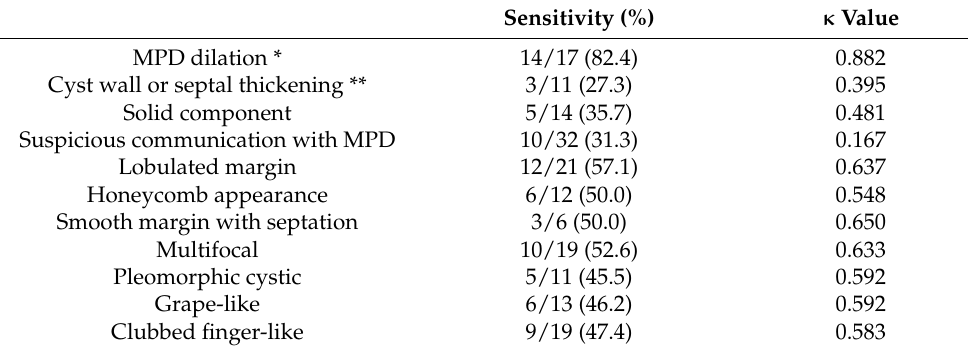
Table 4. Capability of US to characterize PCLs as a reference standard using EUS. Sensitivity (%) κ Value MPD dilation * 14/17 (82.4) 0.882 Cyst wall or septal thickening ** 3/11 (27.3) 0.395 Solid component 5/14 (35.7) 0.481 Suspicious communication with MPD 10/32 (31.3) 0.167 Lobulated margin 12/21 (57.1) 0.637 Honeycomb appearance 6/12 (50.0) 0.548 Smooth margin with septation 3/6 (50.0) 0.650 Multifocal 10/19 (52.6) 0.633 Pleomorphic cystic 5/11 (45.5) 0.592 Grape-like 6/13 (46.2) Clubbed finger-like 9/19